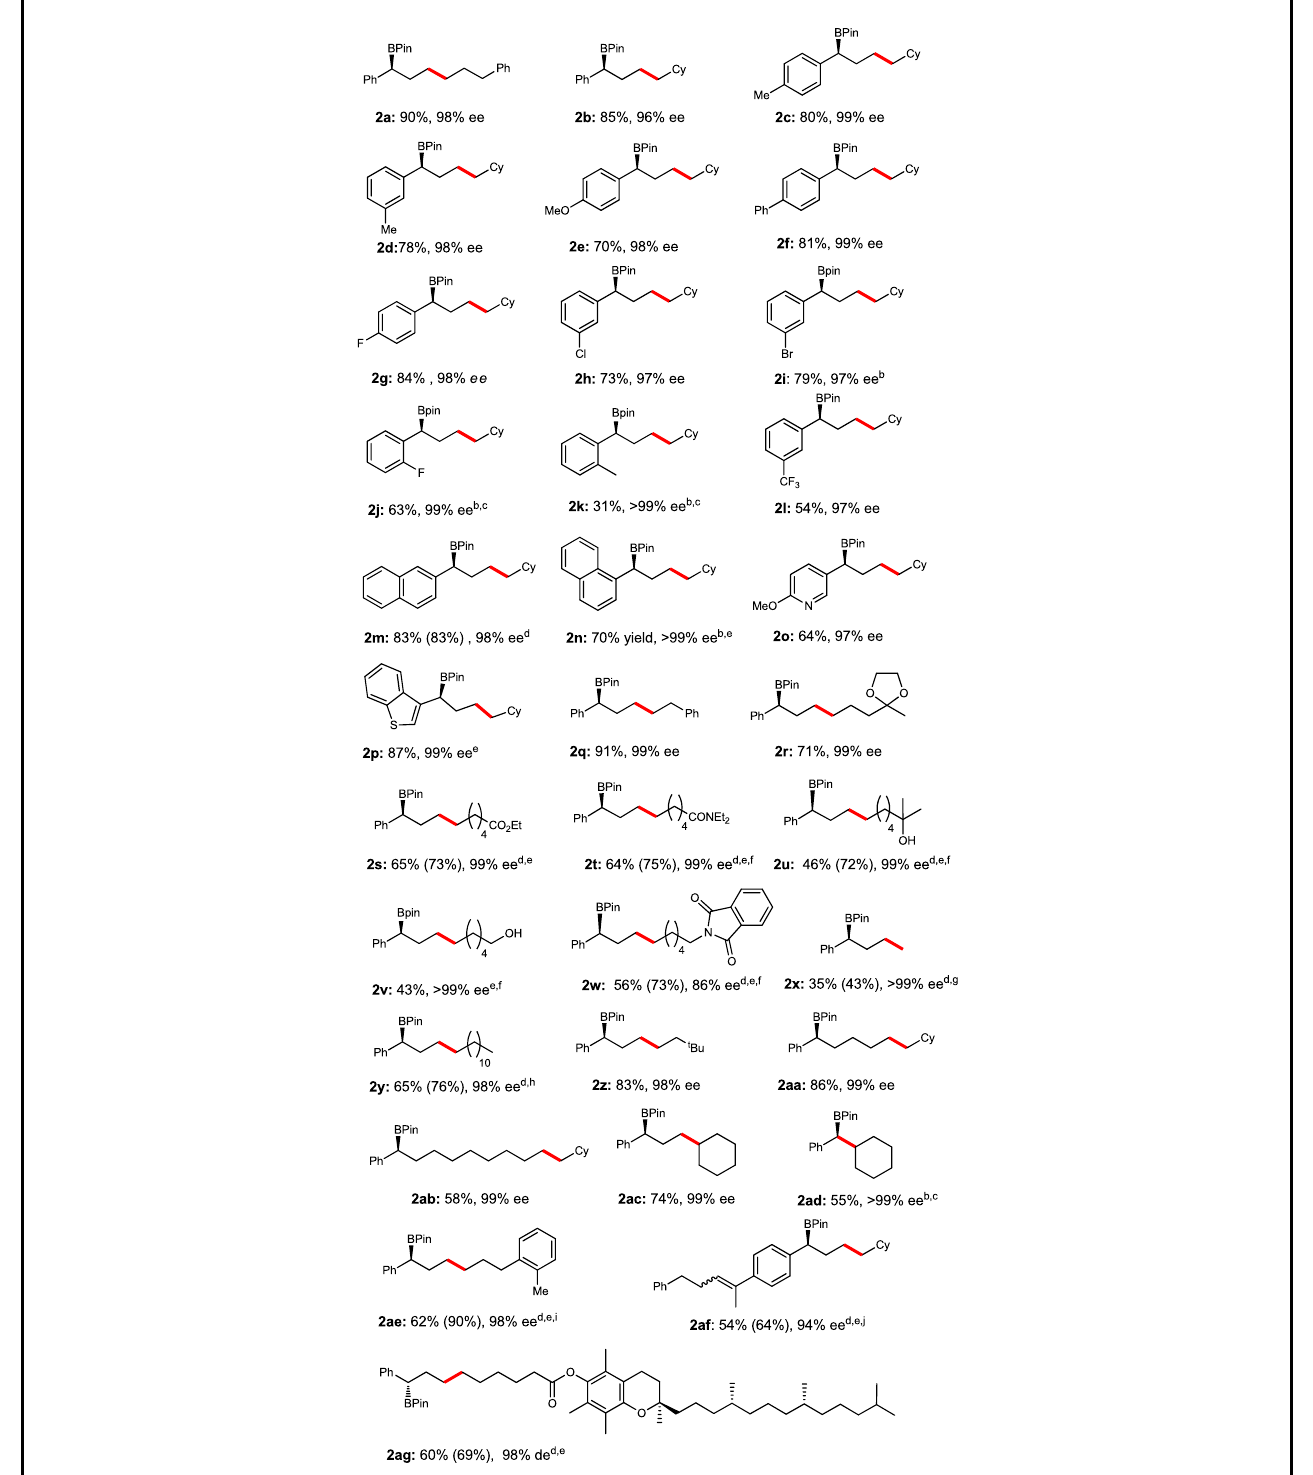
Table 1 Substrate scope of enantioselective isomerization/hydroboration of